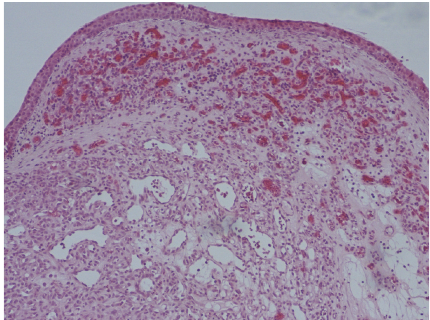
Figure 2: Histopathological analysis of the resected specimen demonstrates capillary haemangioma covered by metaplastic squa- mous epithelium (haematoxylin and eosin stain; original magnifica- tion ×